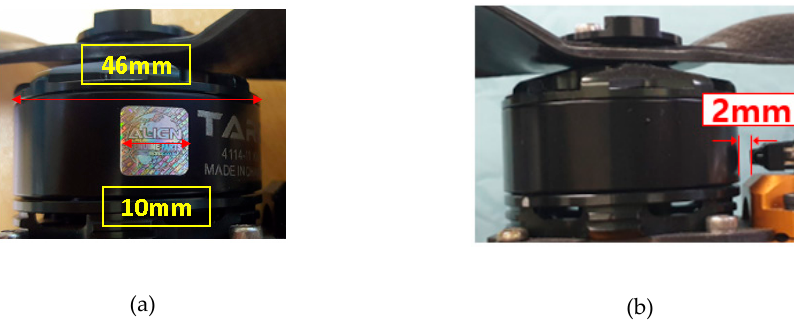
Figure 4. Measuring the rotational speed of the motor using the infrared sensor. ( a ) Diameter of motor and length of reflector; ( b ) the distance between the reflector and the infrared sensor.